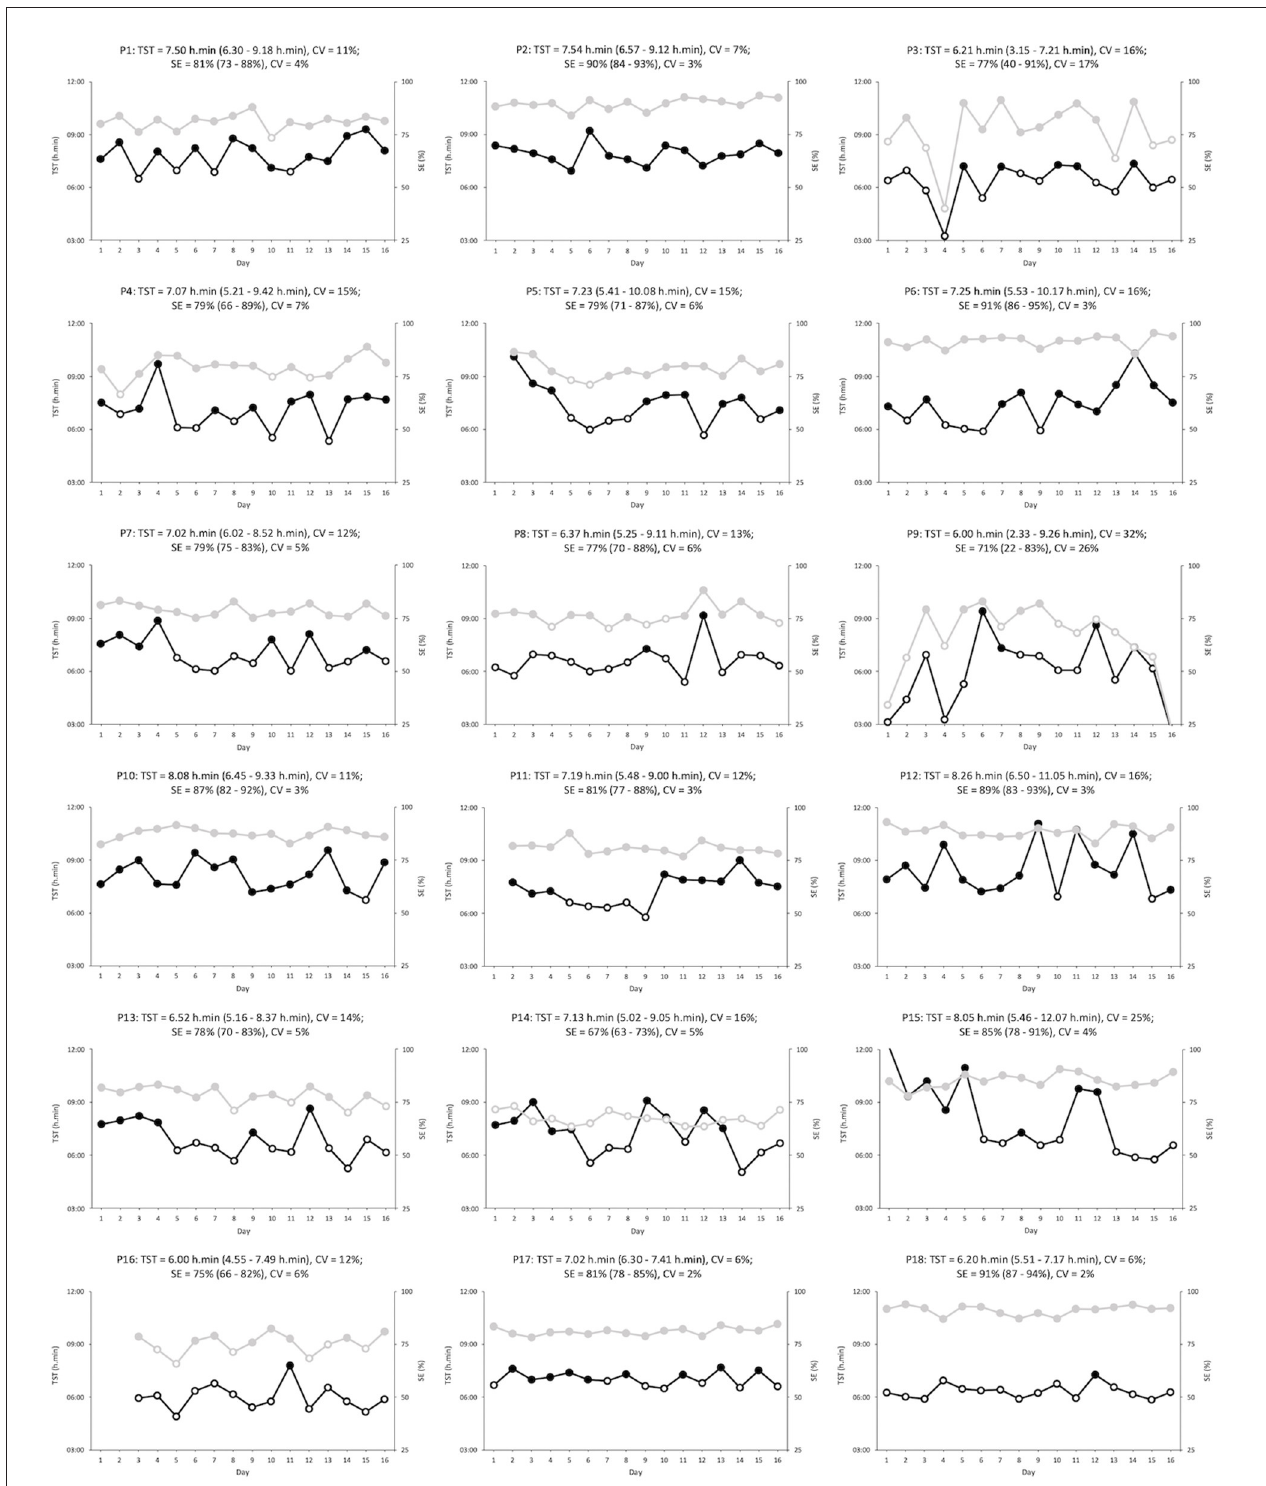
FIGURE 2 | Total sleep time (black) and sleep efficiency (gray) for each participant ( n = 18) over the 16-day period. Open symbols indicate total sleep times below 7.00h.min or sleep efficiencies below 75%. Each heading contains the participant number; the average (with minimum and maximum values), and the variability, for both total sleep time and sleep efficiency. P9 (night 16) = total sleep time of 2.33h.min and sleep efficiency of 22%, and P15 (night 1) = total sleep time of 12.07h.min. P, participant; CV, coefficient of variation; TST, total sleep time; SE, sleep efficiency.